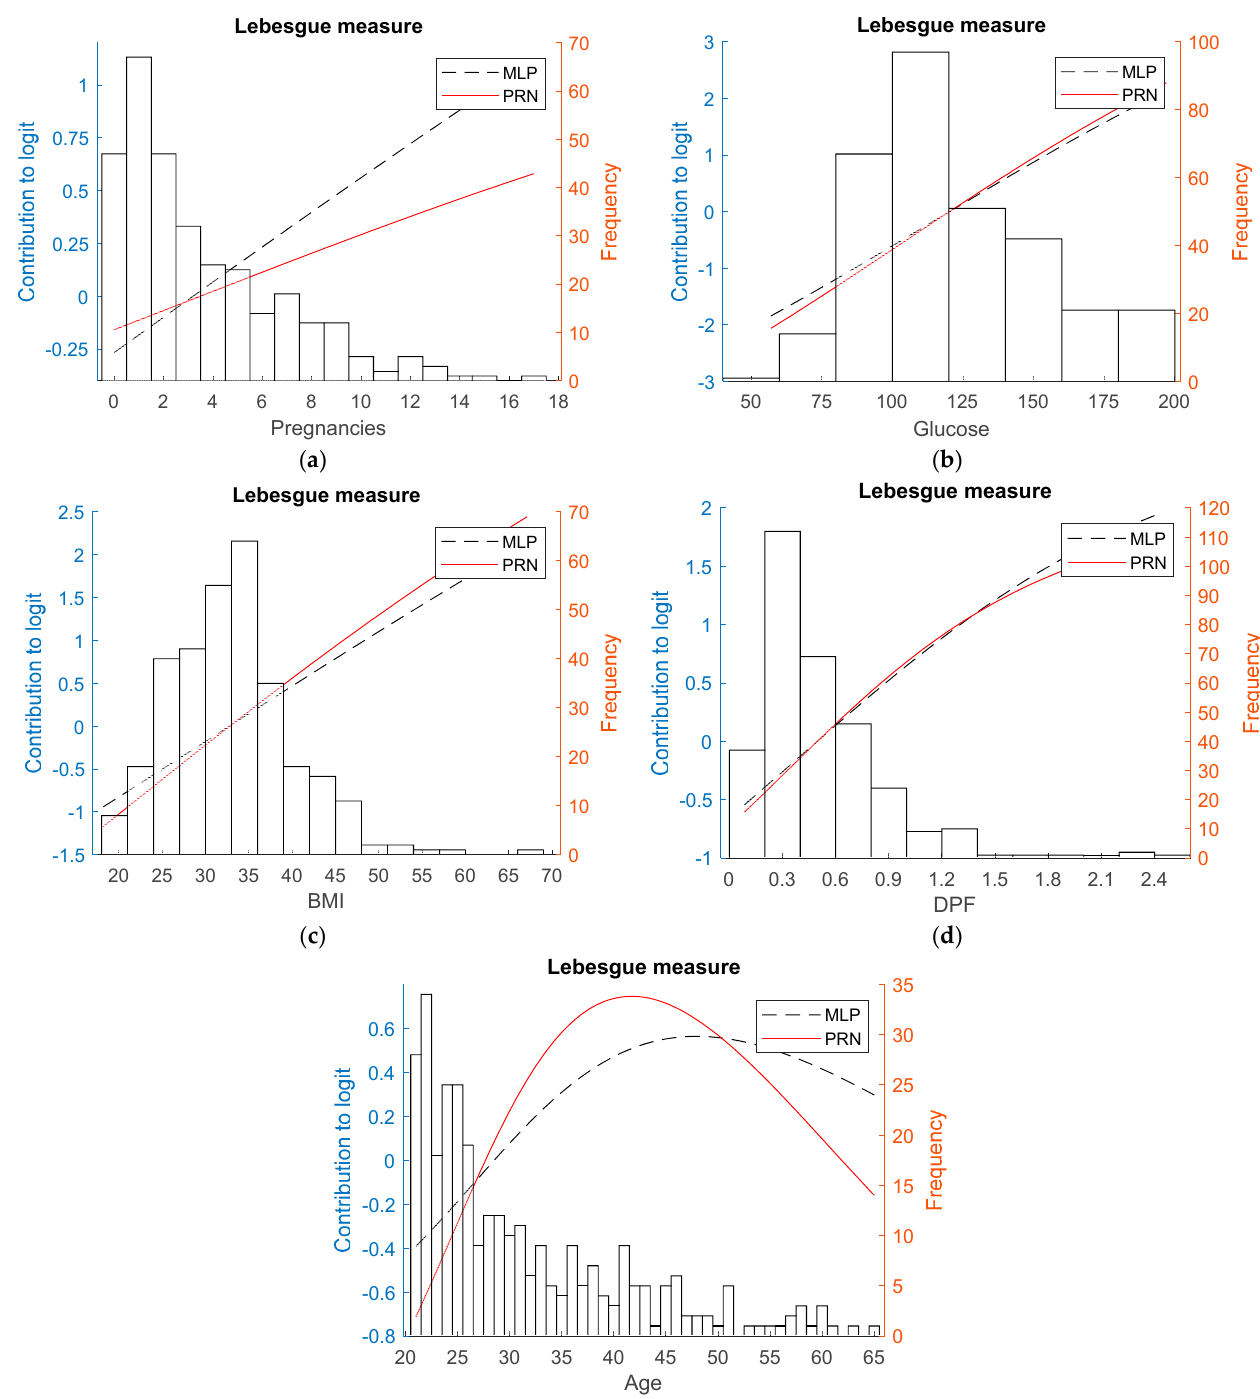
Figure 7. As for Figure 6, with the Lebesgue measure, the component functions of the GAM are very similar for both measures. They have a similar structure and range of contributions to the logit. Despite being fitted with a generic non-linear model, the MLP, several of the partial responses are linear. Variable “DPF” shows a saturation effect, as might be expected, while the log odds of “Age” as an independent e ff ect peak around the age of 40. Note that data sparseness for higher values will result in greater uncertainty in the estimation of the partial response. The same size covariates are represented ( a )–( e ) as in Figure 6.